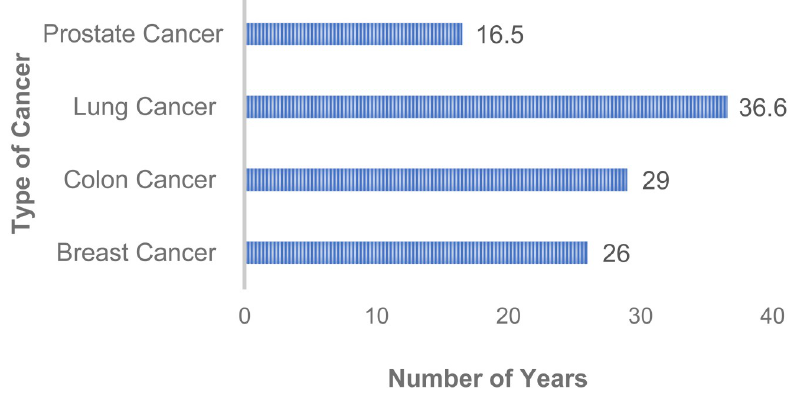
Fig 3. Average of years between asthma and cancer diagnosis.